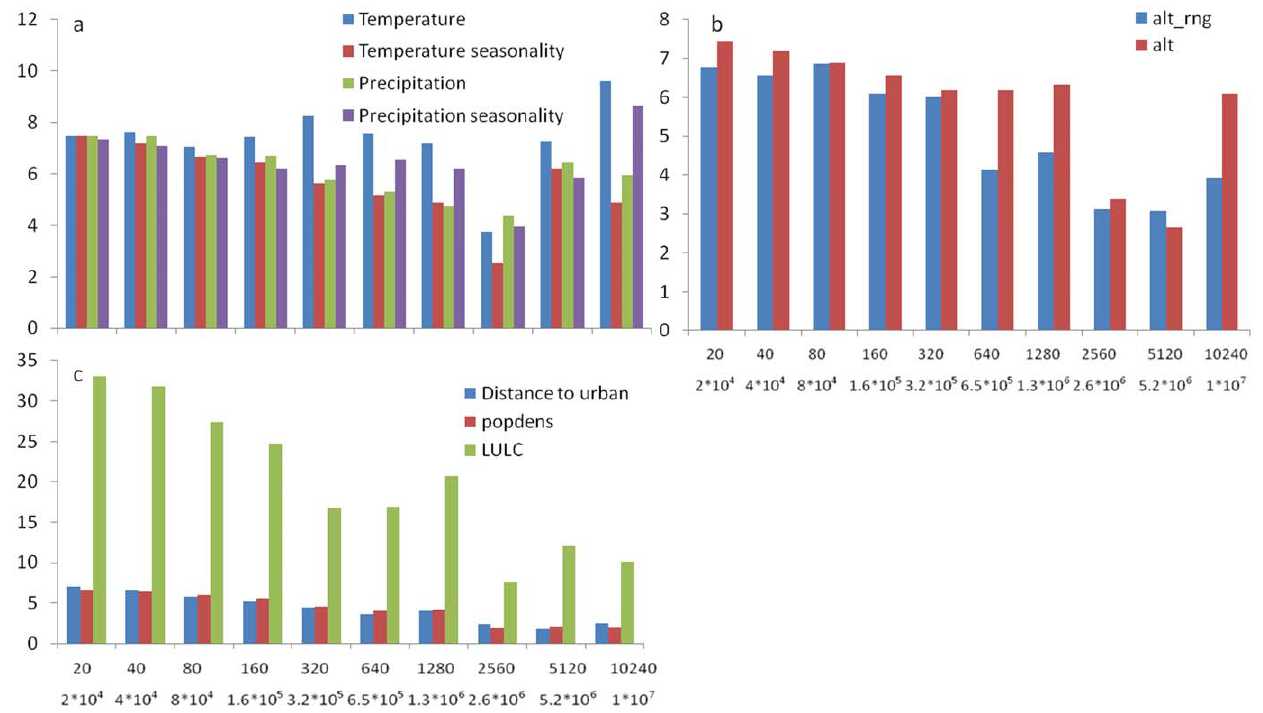
Figure 3. Explained variance rates of individual environmental variables in mammal species composition: a) climatic variables; b) topographic variables and c) LULC variables. Land cover is the combined effect of six land cover categories (agriculture, forestry, open herbaceous, urban, water and wetland). Prec_sea and Temp_sea stand for precipitation seasonality and temperature seasonality respectively; Altitude – rng stands for altitude range; DTU stands for distance to nearest urban area ; and Pop density stands for population density .